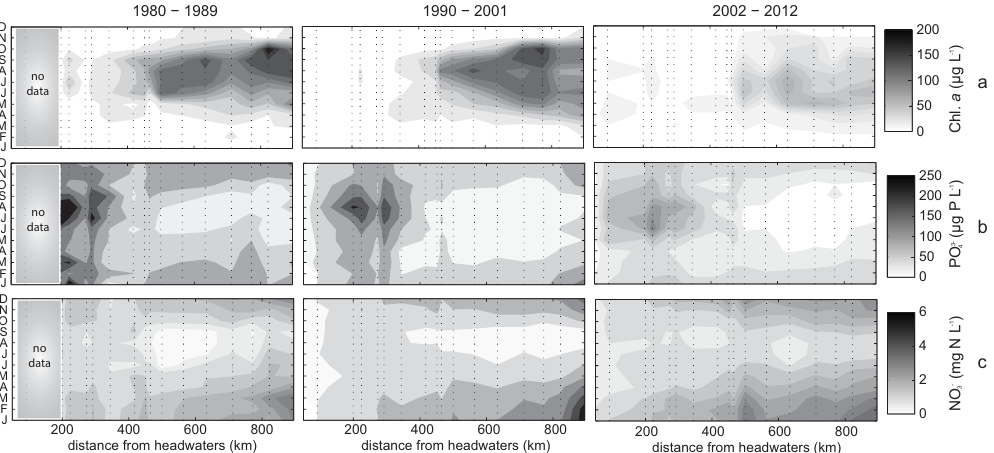
Figure 3. Spatiotemporal diagrams of monthly median levels of Chl a (a) , PO 3 − profile. Dotted vertical lines correspond to the monitoring stations (Fig. 1).